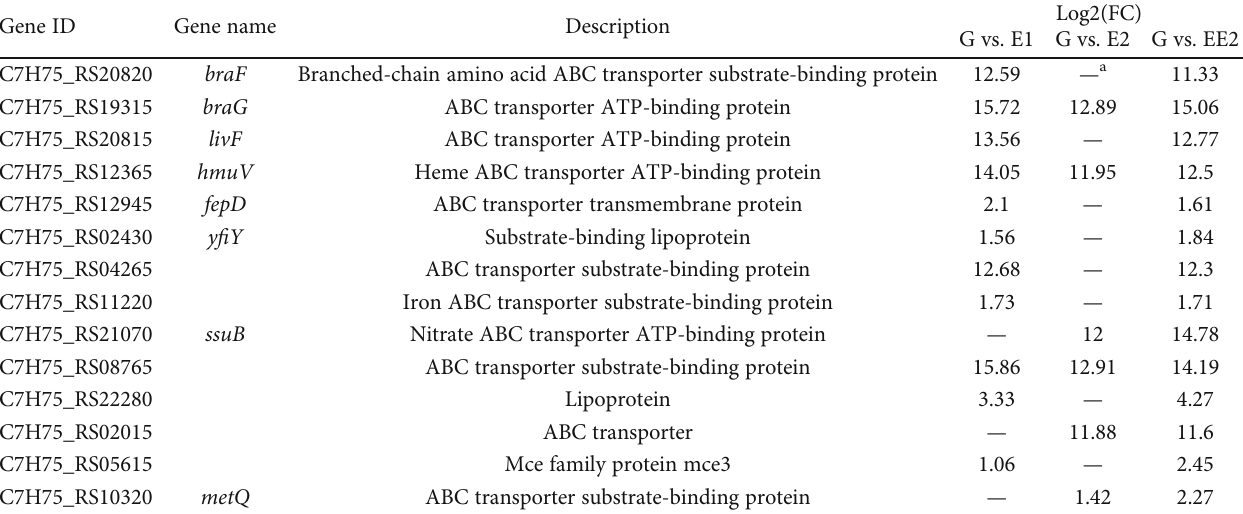
Table 3: DEGs related to estrogen transport in R-001 under di ff erent estrogen